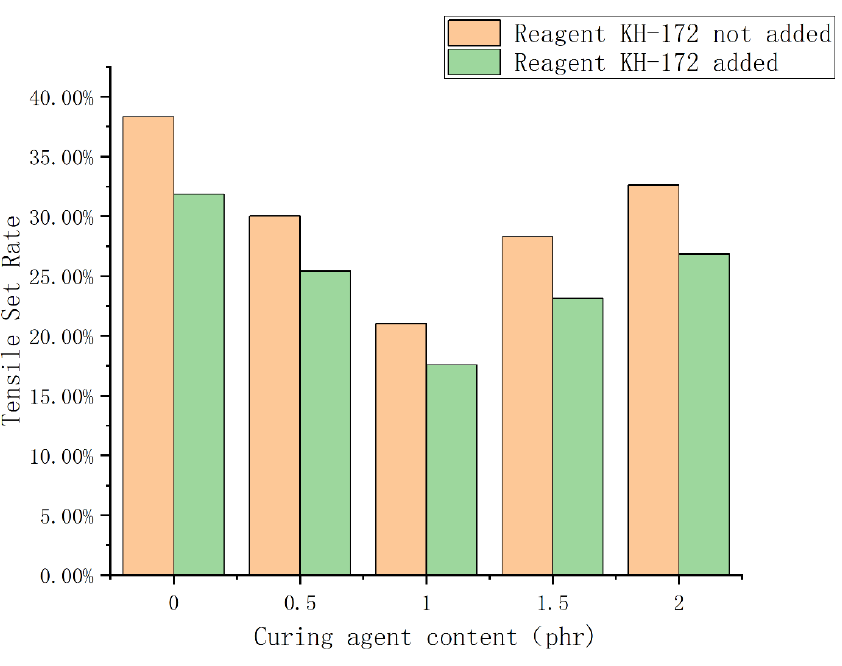
Figure 9. Histogram of tensile permanent deformation of samples 1–5.